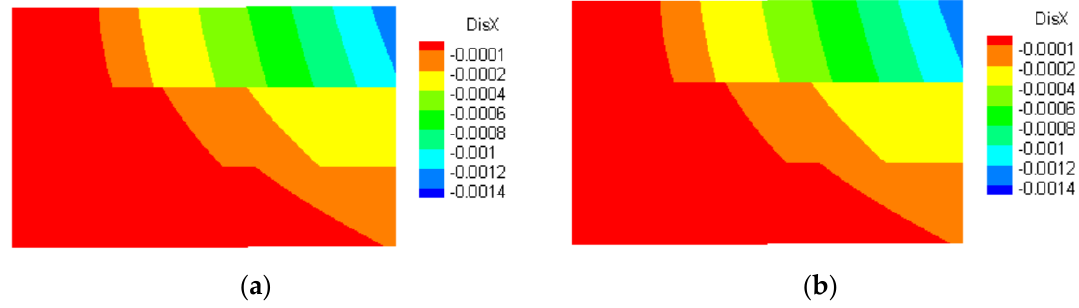
Figure 11. The distribution of displacement in X-direction. ( a ) SBFEM. ( b ) ANSYS.